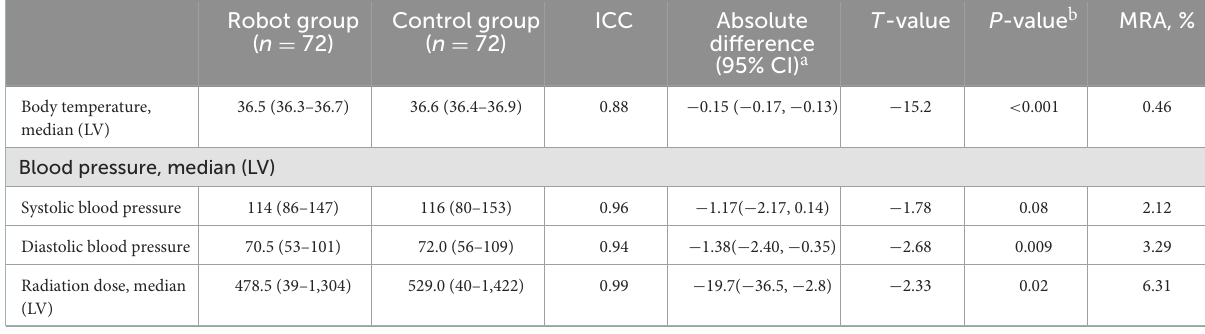
TABLE 3 Secondary clinical outcome of comparison in measurement results.